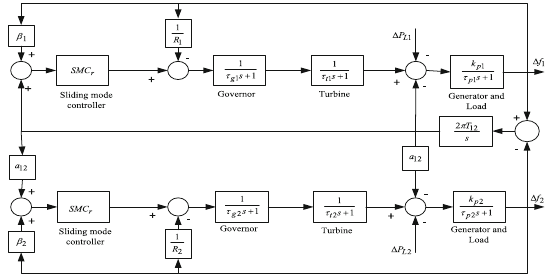
Fig. 9 Two-area interconnected power system